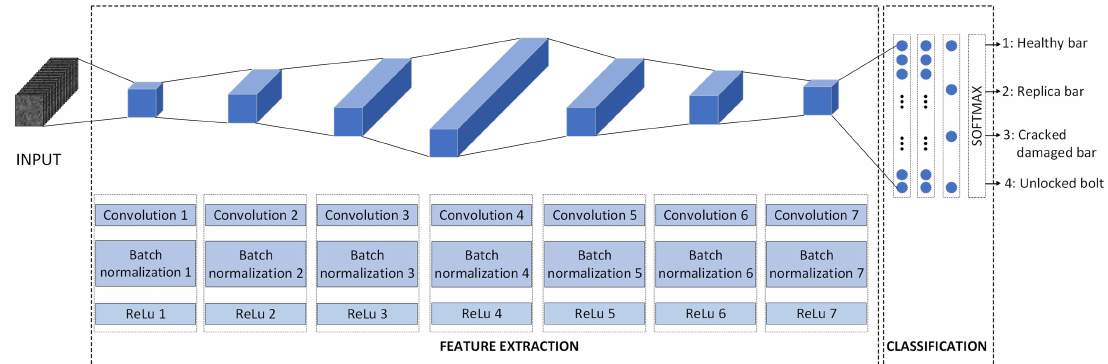
Figure 5. Architecture of the developed convolutional neural network (CNN).